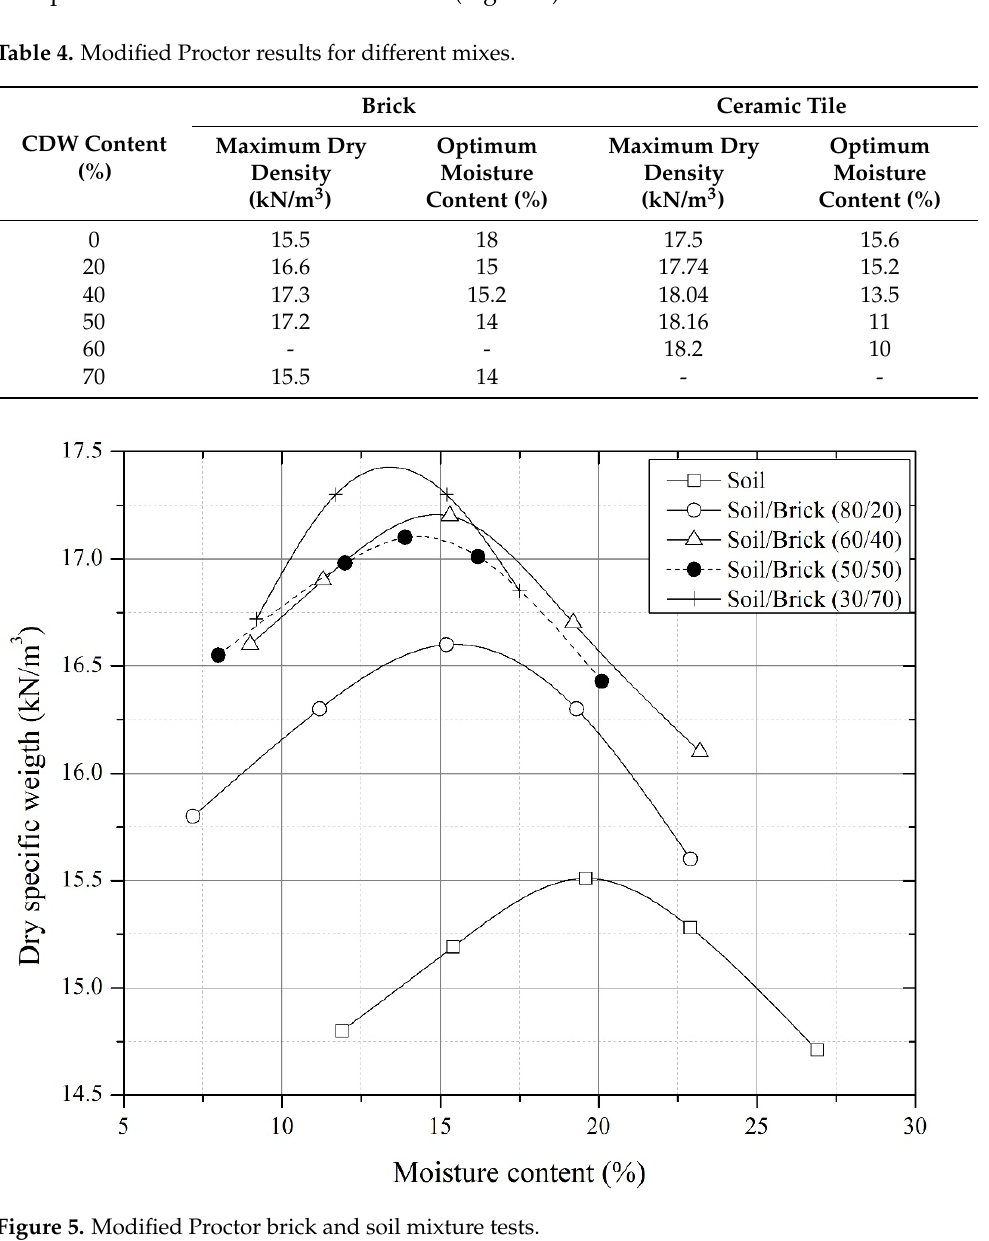
Figure 5. Modified Proctor brick and soil mixture tests.